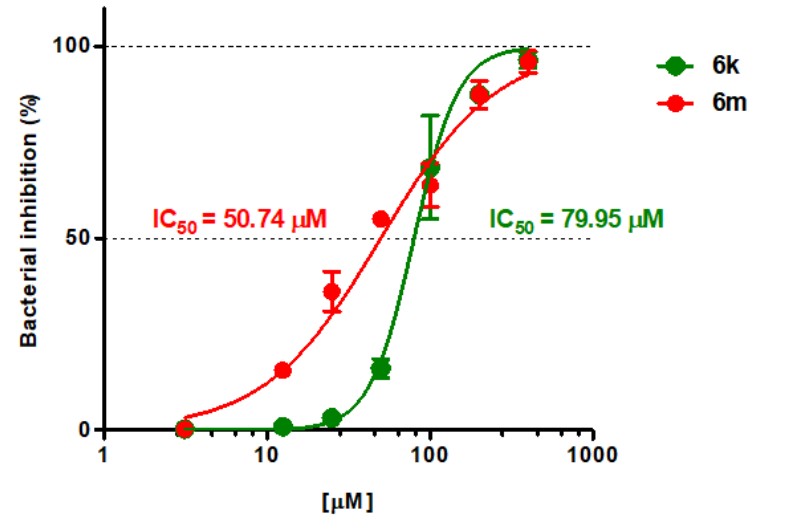
Figure 1. Dose − response curves of derivatives 6k and 6m against S. aureus . Symbols represent mean values with standard deviations, and lines define the curves obtained from nonlinear regression analysis. Percentage values are relative to the positive control.